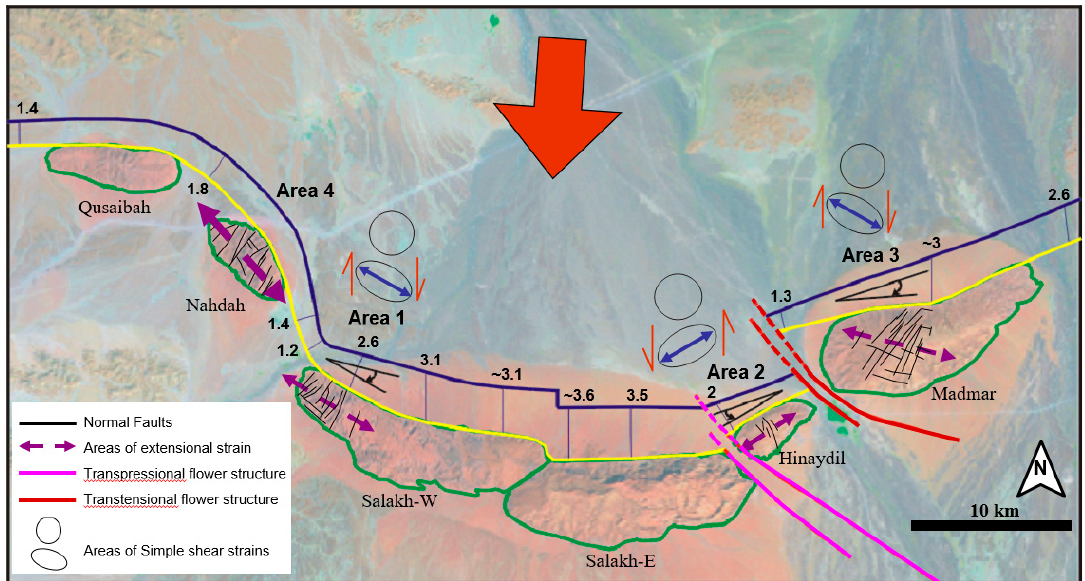
Figure 17. A map-view restoration of the Salakh Arch using the shortening values (in km) measured directly from seismic sections or estimated from surface cross sections. The black lines are normal faults in areas 1, 2, 3, and 4. The pink and dark red lines are transpressional and transtensional flower structures, respectively, as shown in Section 2, Figure